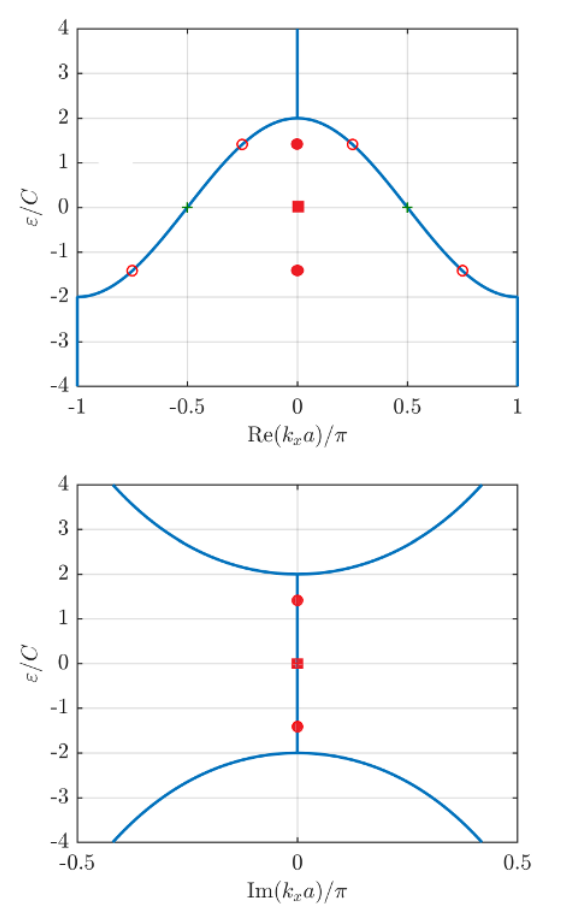
Figure 2. The real and imaginary parts of the band structure of 1D coupled waveguide array shown in Fig. 1. The positions of the states in the vertical waveguide are also indicated: S- modes (full circles) and A-mode (full square). The parameters are C 1 = C 2 = C and δ − 1 = δ 1 =